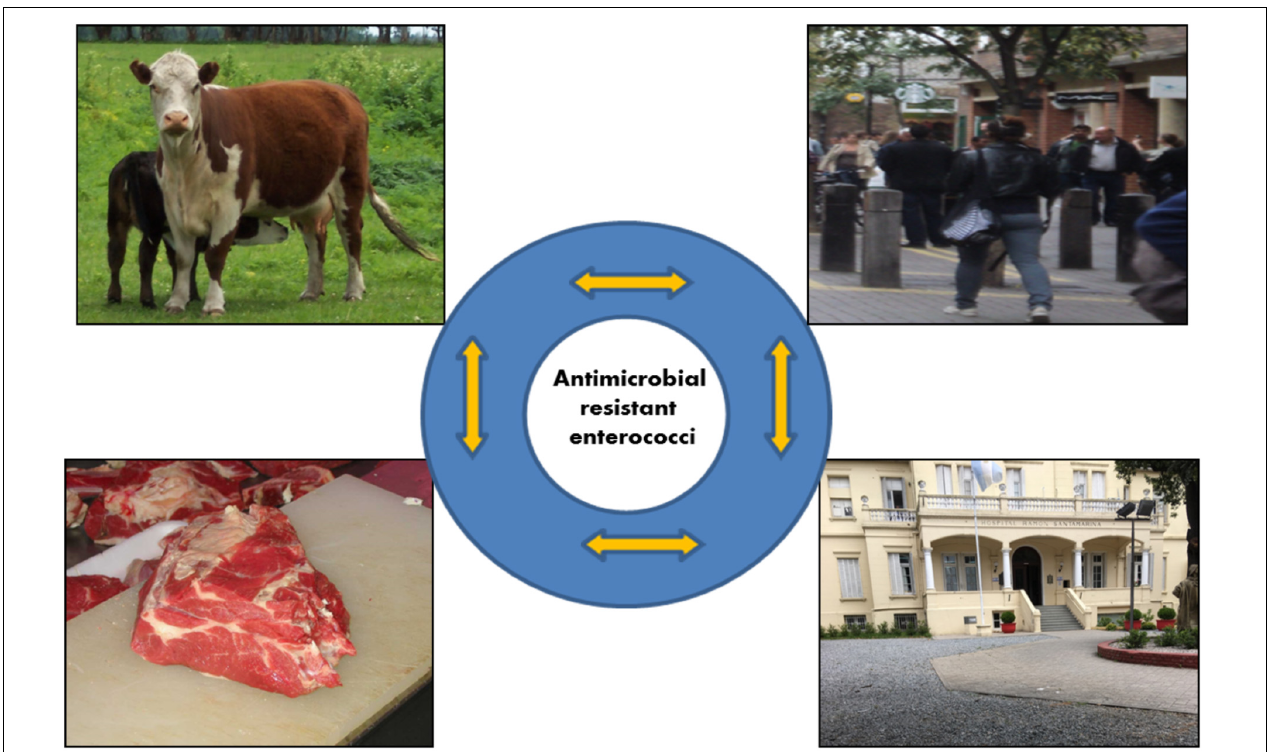
FIGURE 1 | Bidirectional transfer of resistance determinants and/or resistant enterococci between different niches.